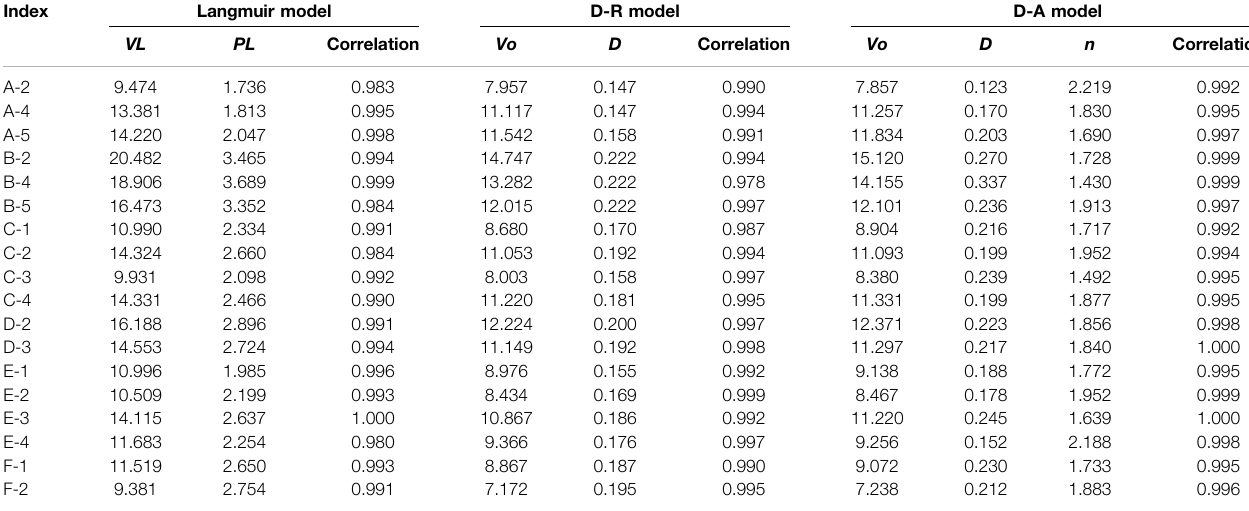
TABLE 2 | Characteristic parameters and fi tting characteristics obtained from fi tting models. Index Langmuir